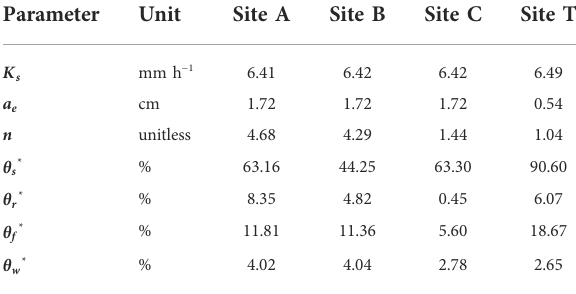
TABLE 2 Parameterization results at sites A, B, C, and T, were calculated by PTFs based on their speci fi c soil